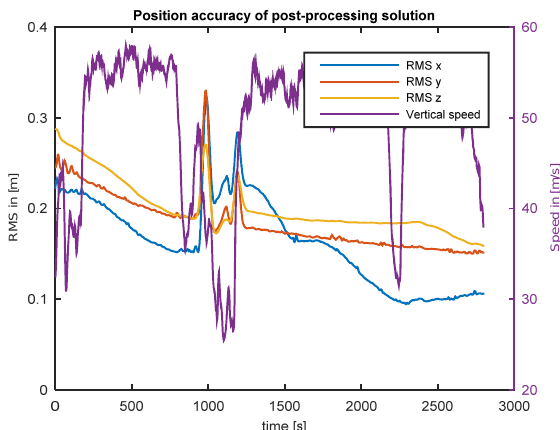
Figure 7: RMS of the sensor position in the post-processing solution (left axis) and vertical speed of the helicopter (right axis) In some cases, the influence of the vertical speed on the RMS errors is visible as the RMS error increases when the vertical speed